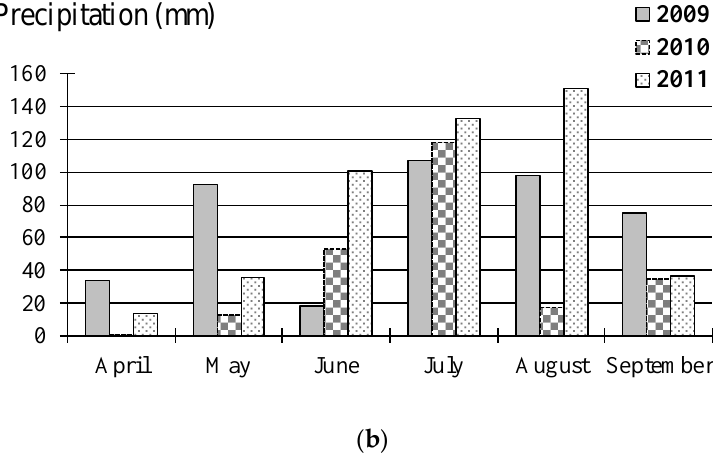
Figure 1. Weather conditions during vegetation seasons, 2009–2011, ( a ) average air temperature in months, ( b ) total rainfall in months.